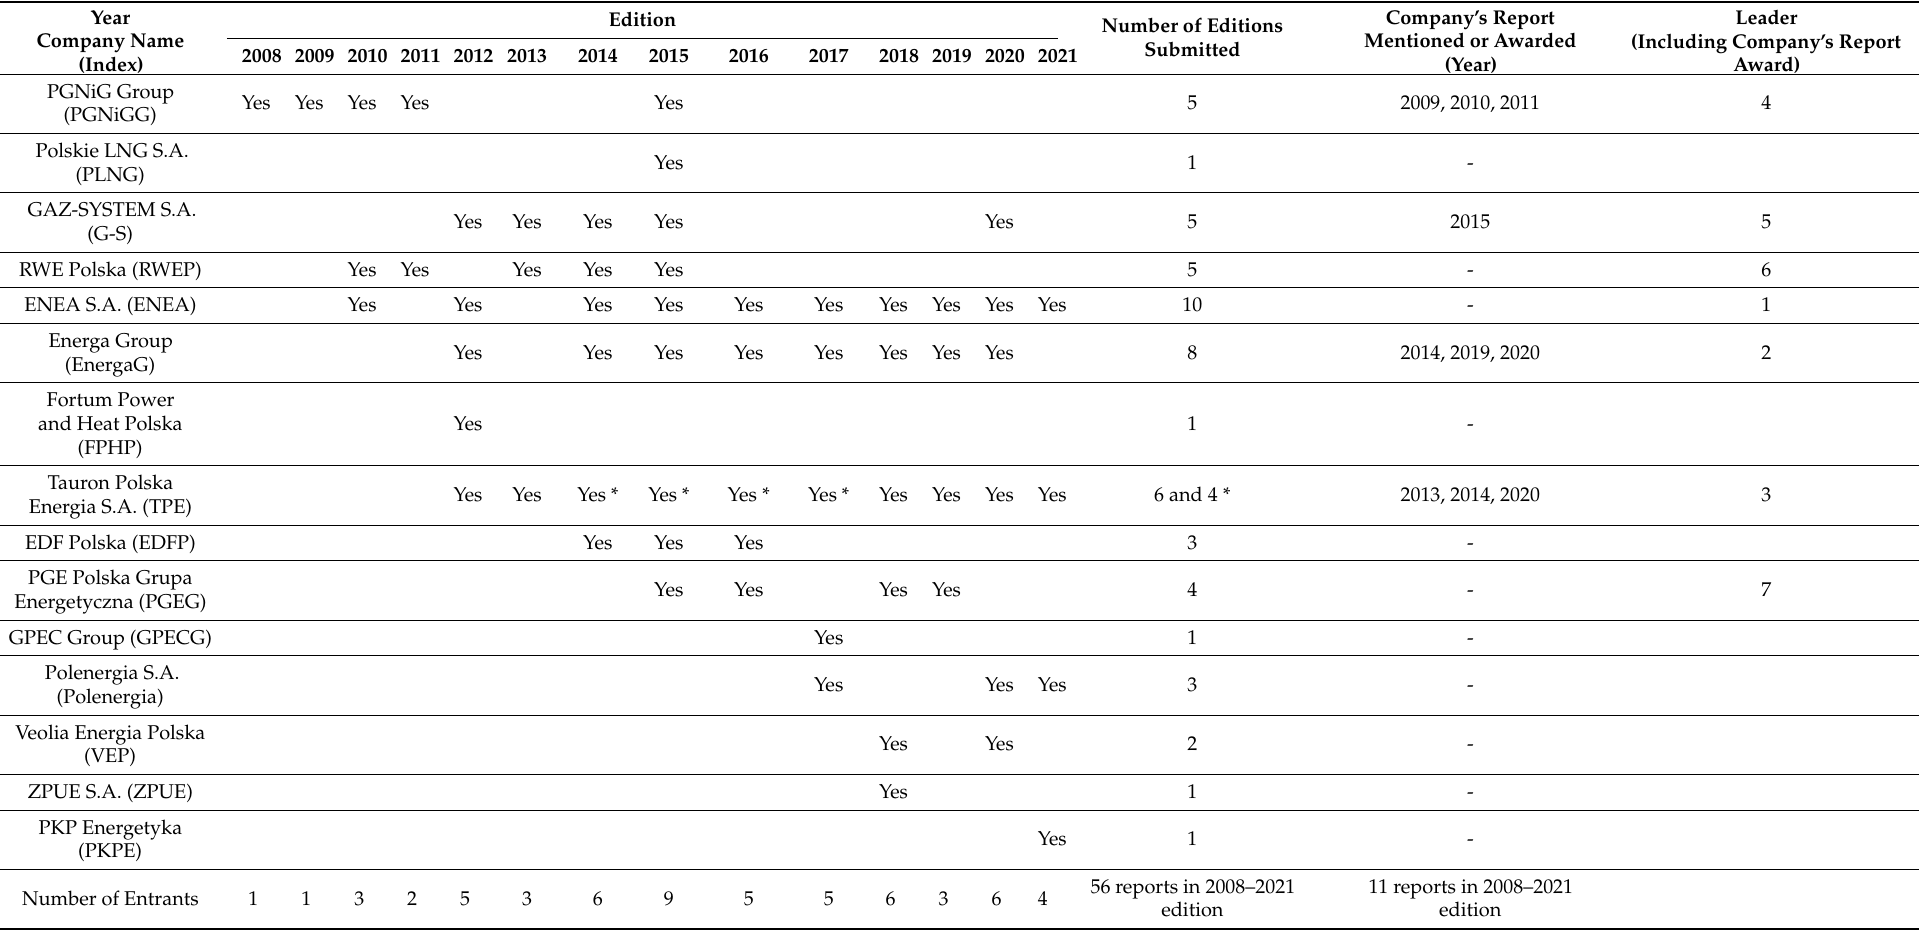
Table 2. Overview of energy companies participating in “The Best CSR Report in Poland”